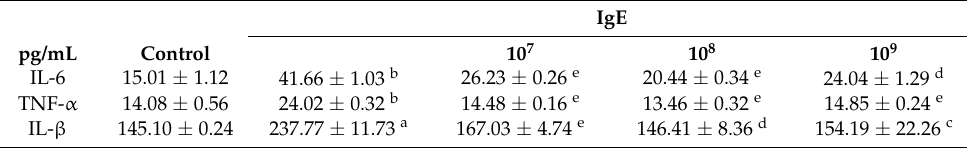
Table 1. Expression of inflammatory cytokine in the culture medium of KU812